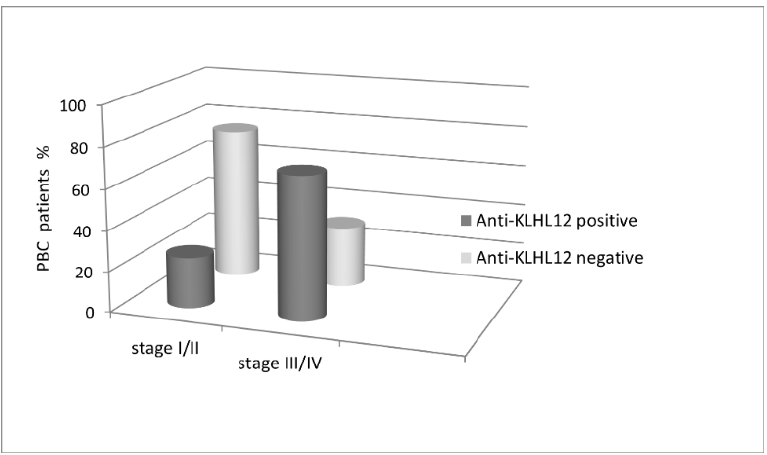
Figure 11. Presence of anti-KLHL12 antibodies and the stage of liver fibrosis in PBC patients. Among 82 PBC patients with early histological stages (I/II) of the disease, only 20 (24%) were positive for anti-KLHL12 antibodies. We found a statistically significant dif- ference in comparison to the group of PBC patients with advanced histological stages (III/IV), where 39 out of 52 (75%) subjects were positive for anti-KLHL12 antibodies ( p <